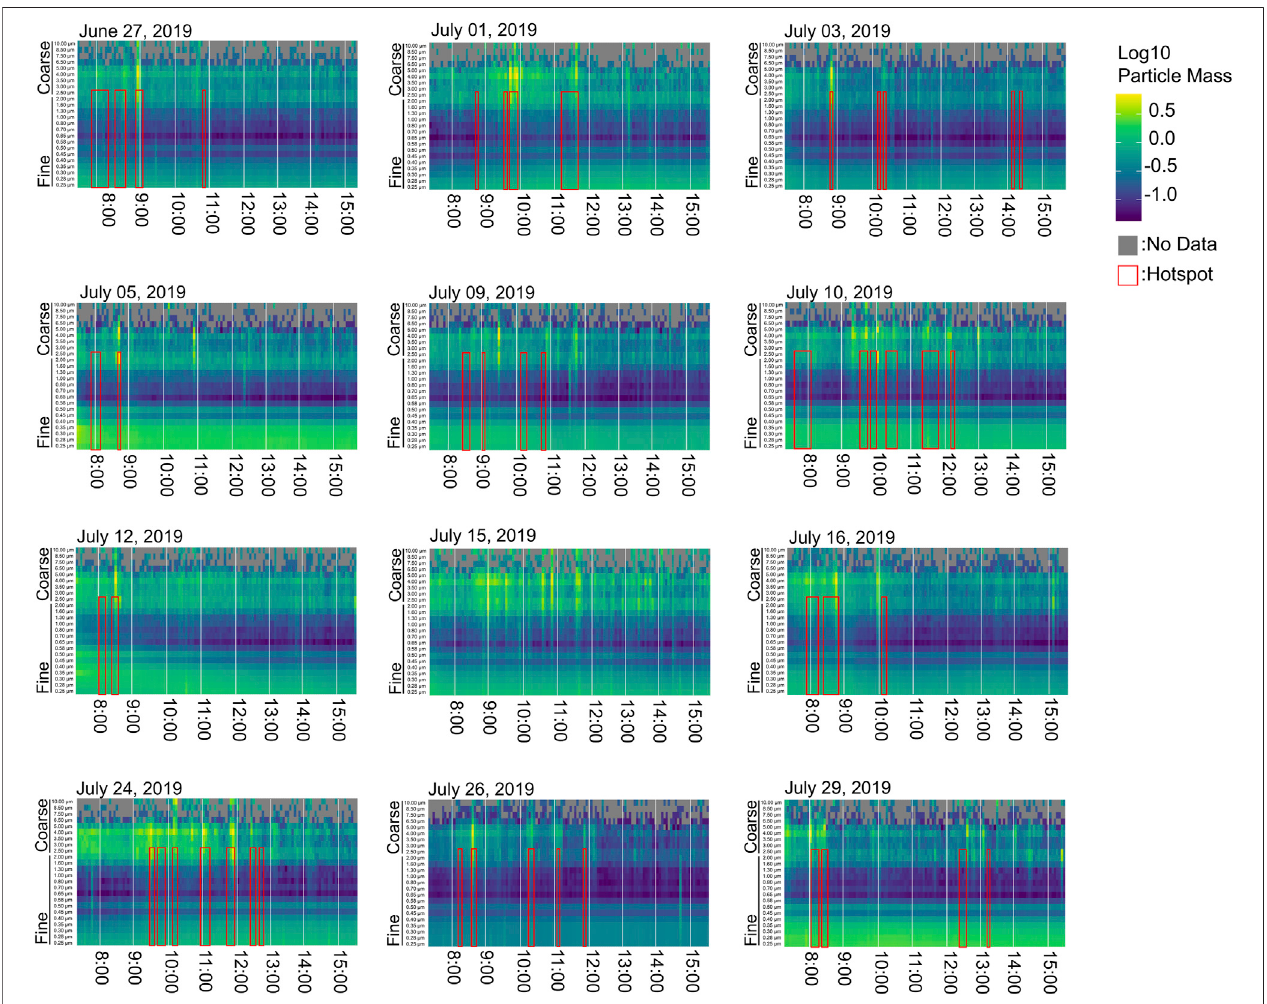
FIGURE7| Heatmapoflog 10 PMmassvaluesacross24 fi neandcoarsesizefractionsthroughouteachdayofdatacollection.Timeofdayisdenotedonthex-axis. Hotspots for PM 2.5 fraction covering > 2 min periods are identi fi ed by vertical red boxes. July 15, 2019 was excluded from hot spot analysis; as such, no hotspots are identi fi ed. As this is a large multi-panel image, we encourage the reader to download and zoom in if interested in particle mass concentrations of speci fi c size fractions.